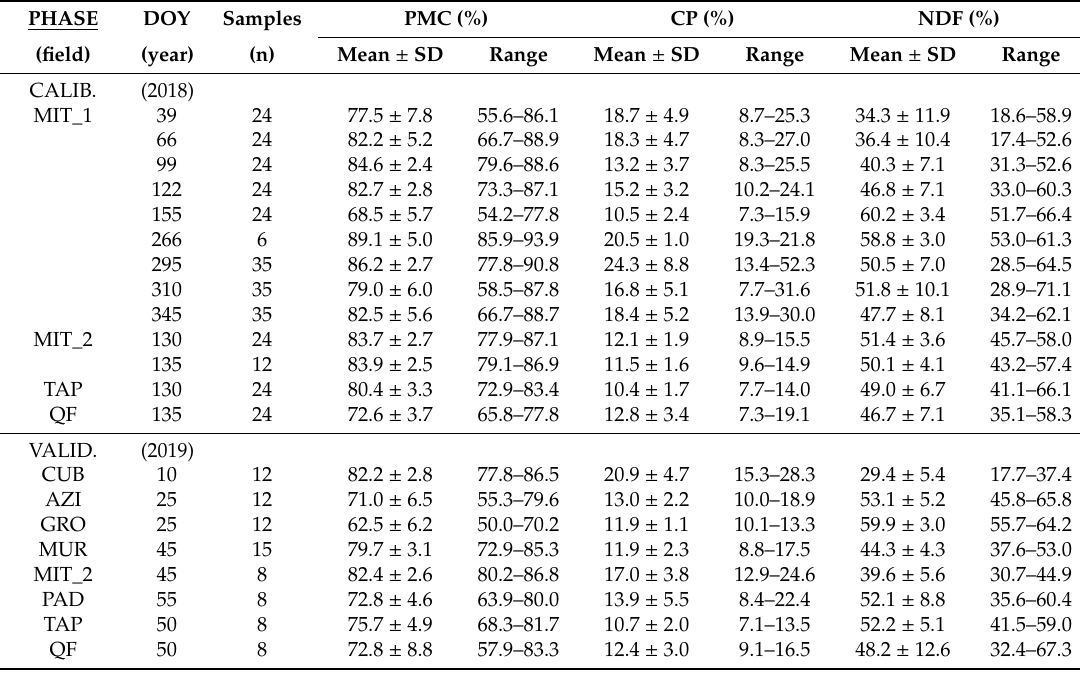
Table 2. Pasture moisture content (PMC), crude protein (CP), and fiber (NDF) reference values of calibration phase and external validation phase.